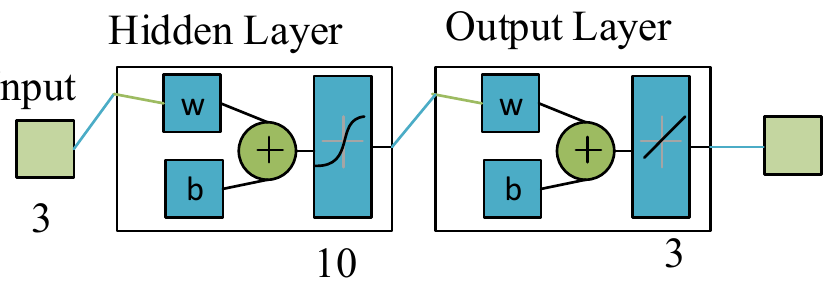
Figure 12. Series neural network.